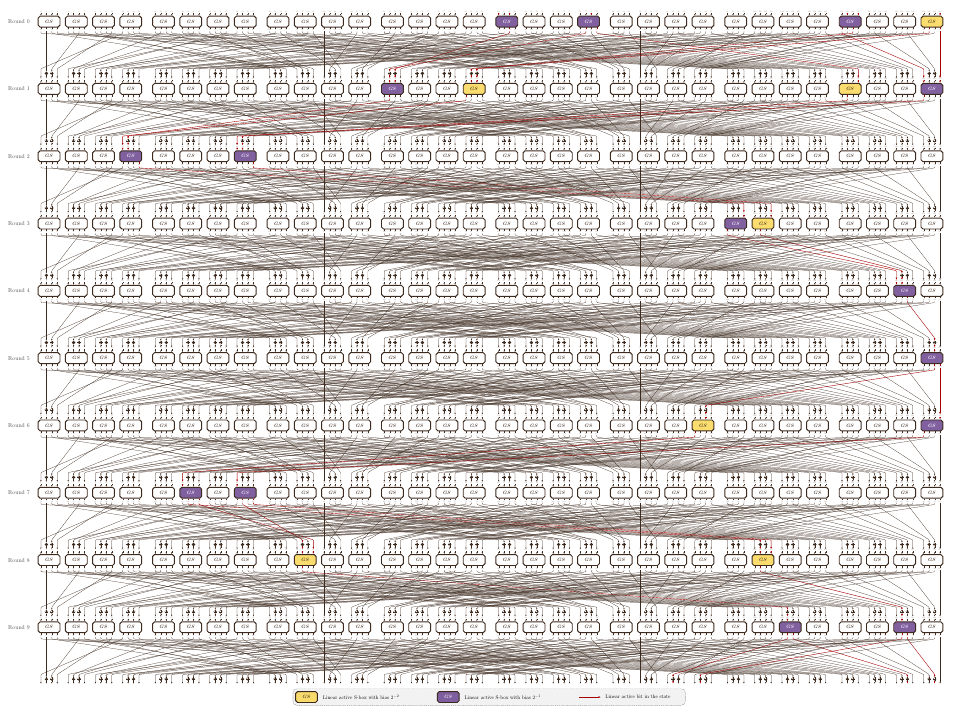
Figure 4: 10-round trail with c = 2 − 29 in the approximation concerning GIFT-COFB . The dominating linear characteristic with correlation c = 2 − 28 is shown in Figure